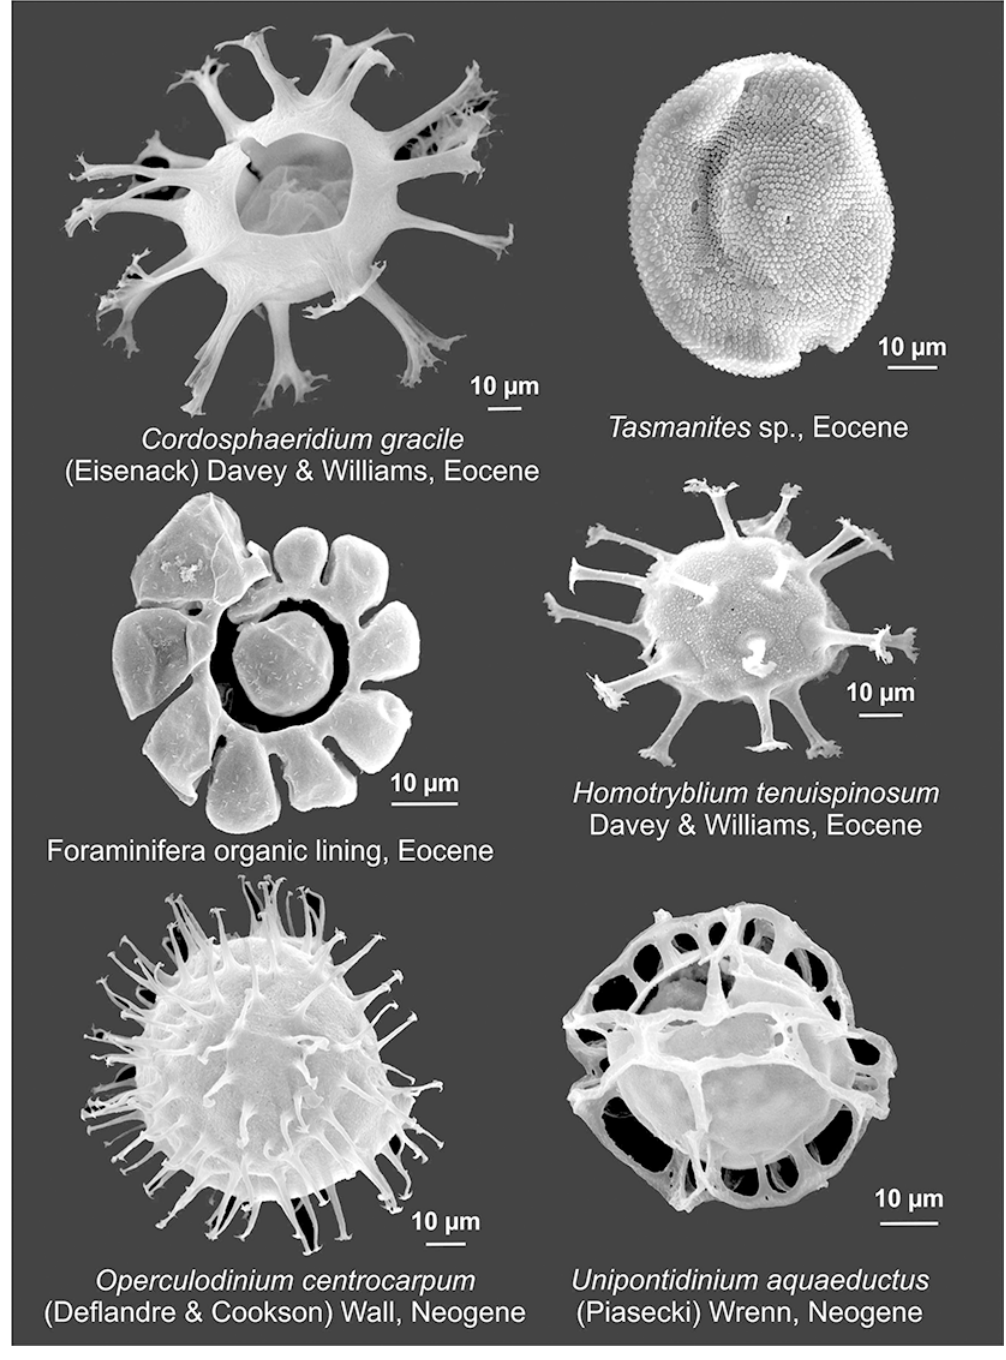
Figure 5 Dinocysts, Chlorophyta algae, and foraminifera organic lining from Paleogene and Neogene deposits. Photo: P.